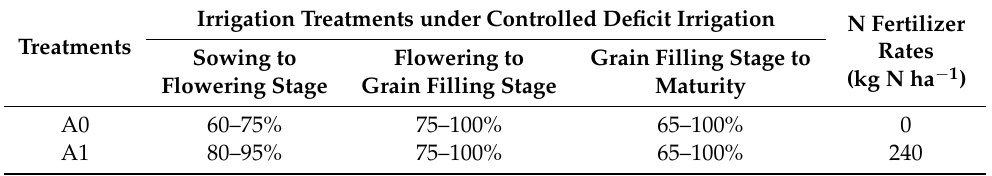
Table 3. Detailed irrigation and fertilization treatments for the auto-rain-shelter